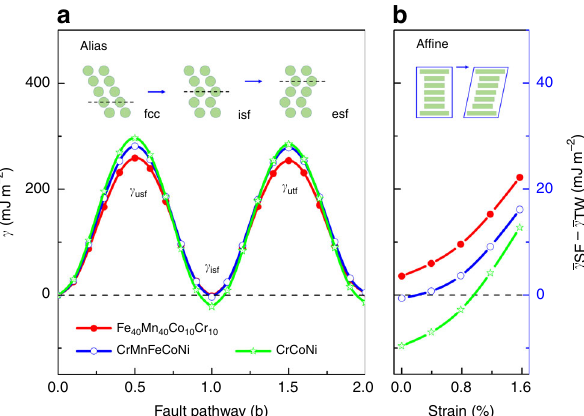
Fig. 3 Generalized stacking fault energy curves for the Fe 40 Mn 40 Co 10 Cr 10 , CrMnFeCoNi, and CrCoNi alloys at room-temperature. In panel a , b ¼ (cid:1) 2 1 h 11 i is the Burgers vector of the partial dislocation (in units of fcc lattice 6 parameter). γ , intrinsic stacking fault energy; γ isf , unstable twining fault energy. Panel b shows (cid:1) γ energy; γ utf